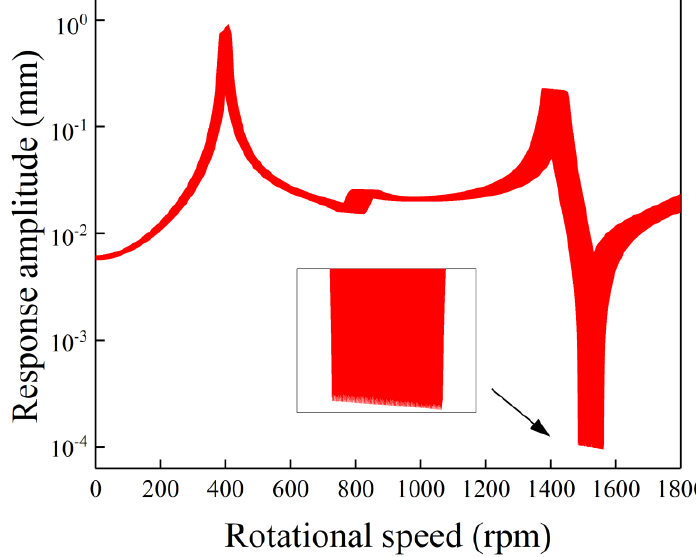
Figure 9. The bounds of uncertain gravity response versus rotational speed by CIM with a 10% deviation in bearing’s stiffness and a 5% deviation in Young’s modulus.